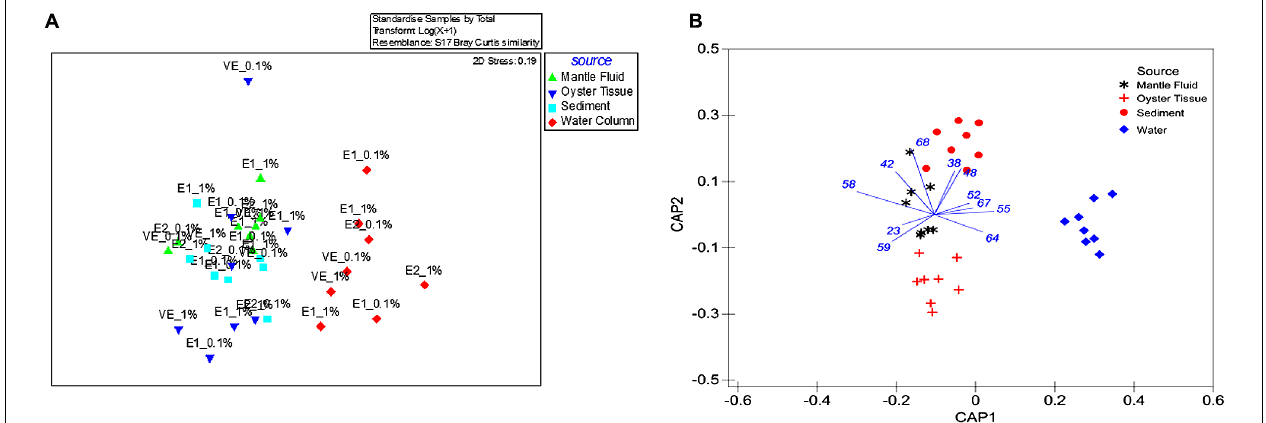
E1 (first enrichment), E2 (second enrichment) and VE (vapor enrichment); (B) CAP on the ITS region gene sequences obtained by ARISA with sample source as the grouping factor. 1 and 0.1% denotes the percentage of crude oil amended in each of the enrichment